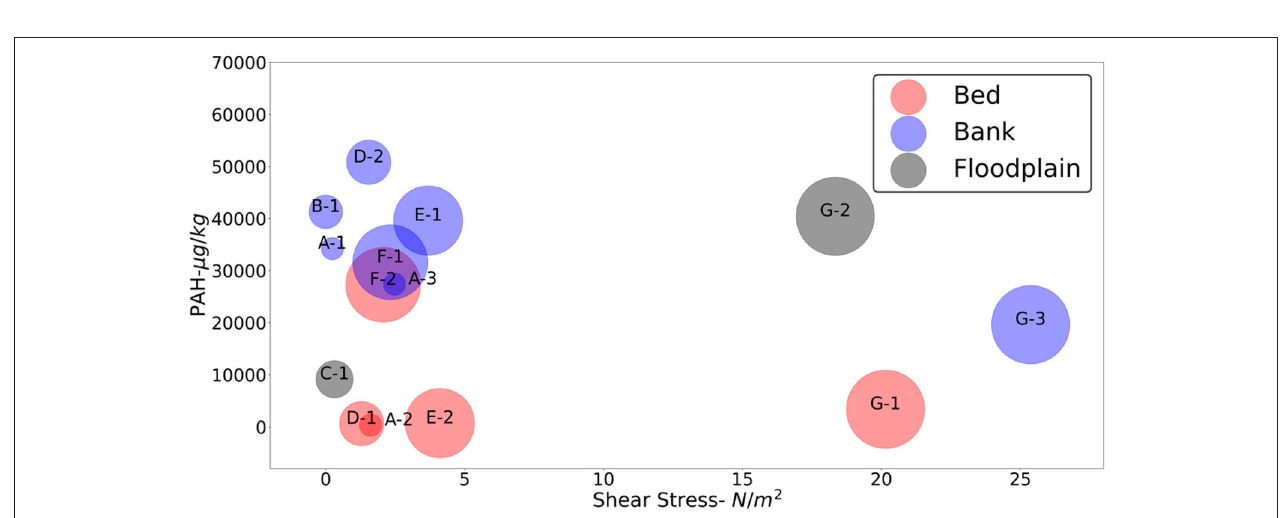
FIGURE 7 | PAHs concentration distribution in the creek (going from upstream—A to downstream—G). Erosional sites included A1, D2, E1, and G3. Depositional sites included A3, B1, C1, F1, F2, and G2. Missing circles indicate the lack of measured data. The bubble size demonstrates the scale of PAHs concentration.